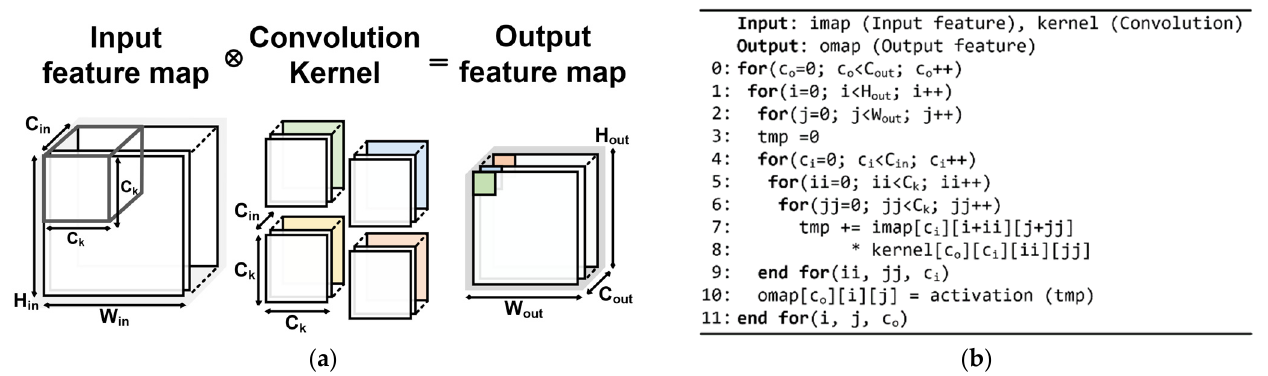
Figure 1. Example computation in a convolution layer: ( a ) Illustration of a convolution operation between an input feature map and convolution kernel; ( b ) Pseudocode for a typical computation in a convolution layer.